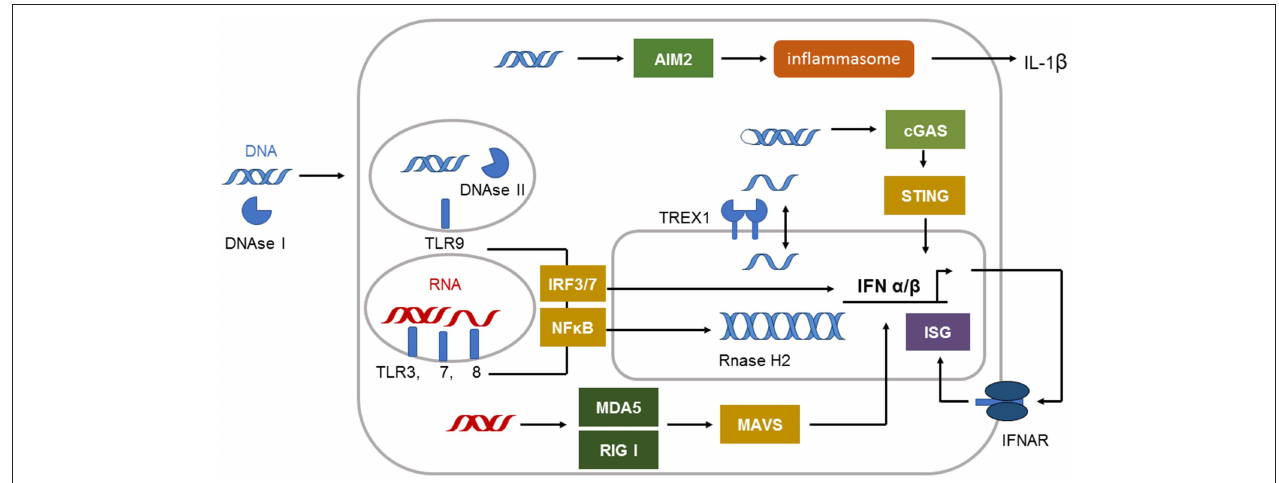
FIGURE 1 | Immune sensing pathways for RNA and DNA in the cell. The compartmentalization of nucleic acids in the cells is strictly regulated. Unrestricted RNA and DNA in the cytosol is a danger signal and can be sensed by specific receptors. The cytosolic immune receptor cyclic GMP–AMP synthetase (cGAS) detects long double-stranded DNA (dsDNA) or highly structured single-stranded DNA (ssDNA) in a special conformation. cGAS signals via STING to induce type I IFN induction. dsDNA can also be recognized by the inflammasome sensor AIM2 leading to IL-1 β secretion. Cytosolic DNA is efficiently degraded by 3 ′ repair exonuclease 1 (TREX1) located in the outer nuclear membrane. DNAse II is restricting DNA in the endolysosome. Endosomal DNA can be detected by Toll-like receptor 9 (TLR9). TLR9 signals via interferon (IFN)-regulatory factor 7 (IRF7) and nuclear factor- κ B (NF- κ B) to induce type I IFN. dsRNA is detected by TLR3 and TLR7, whereas single-stranded RNA (ssRNA) is sensed by TLR7 and TLR8 in the endosome. These receptors signal via adaptor proteins to induce interferon (IFN)-regulatory factor 3 (IRF3)–IRF7 and type I IFN production and via nuclear factor- κ B (NF- κ B) to induce proinflammatory cytokines. The cytosolic sensors melanoma differentiation associated gene 5 (MDA5) and retinoic acid inducible gene I (RIG-I) detect dsRNA. Both signal through mitochondrial antiviral signaling protein (MAVS) to induce type I IFN